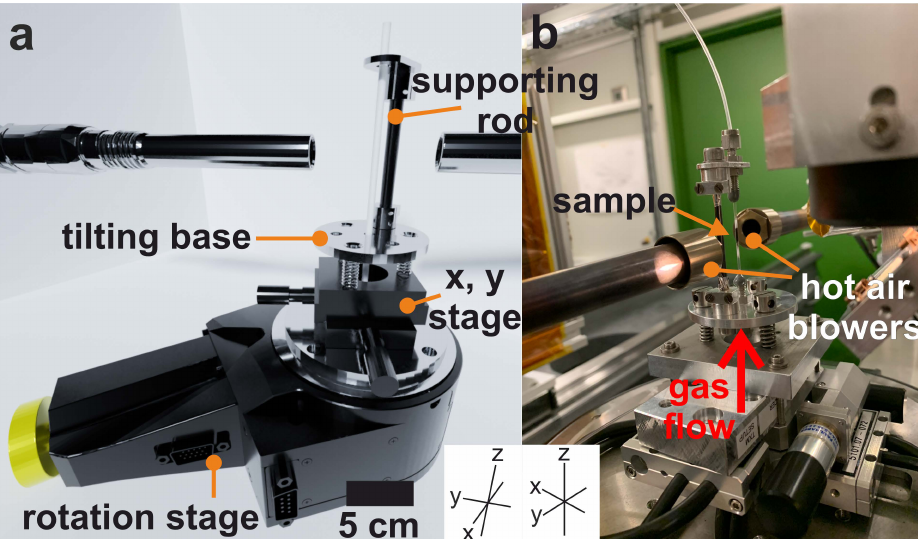
Figure 1. ( a ) 3D rendering of the rotating capillary for tomographic in situ/operando catalysis (aRCTIC) setup; ( b ) aRCTIC installed at the microprobe end station of beamline P06 at PETRA III—showing 1 mm quartz capillary mounted with support rod, twin hot air blowers and gas- tight